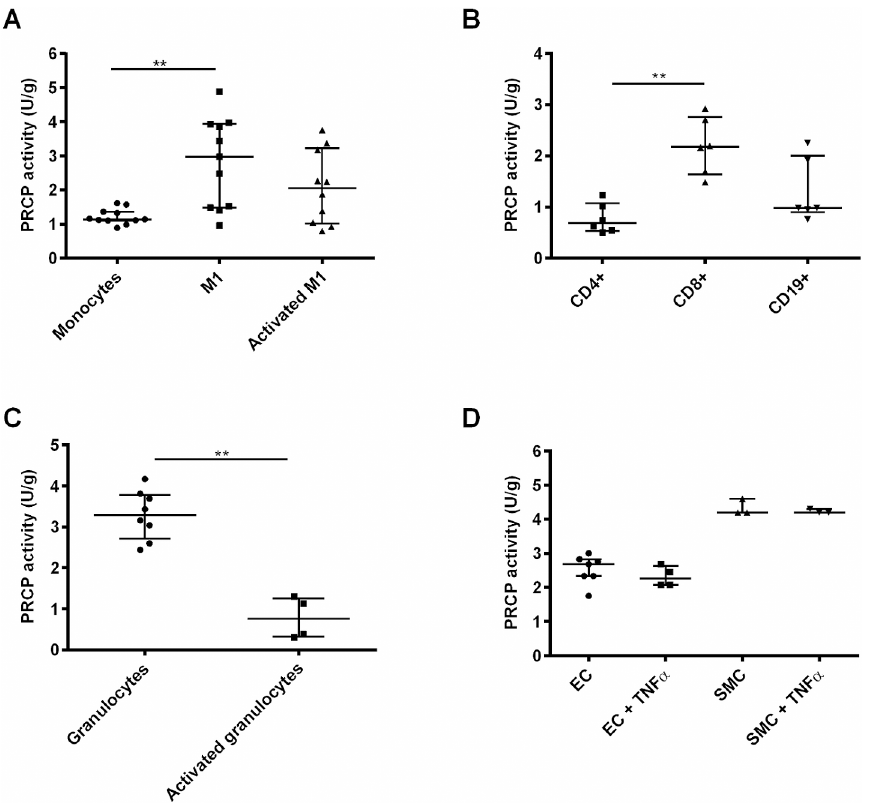
Fig 2. PRCP activity in primary human cells. (A) PRCP activity was significantly increased upon monocyte-to- macrophage (M1 phenotype) differentiation. (B) PRCP activity was measured in different subsets of lymphocytes and was found highest in CD8 + cytotoxic T cells. (C) PRCP activity was measured in resting and PMA-activated granulocytes and (D) in control and stimulated (TNF α , 24h) human aortic endothelial and smooth muscle cells. ( (cid:3)(cid:3) p < 0.01, n = 3–11 per